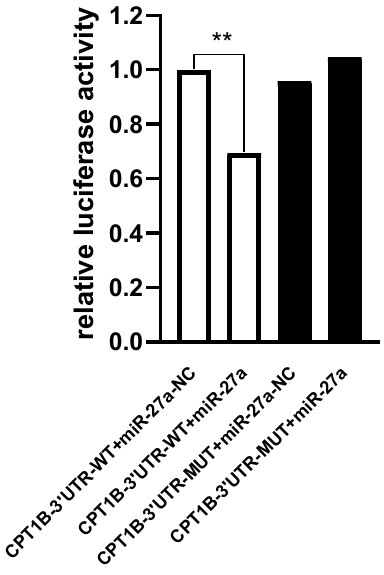
Figure 6. ( A ) Sequence alignment of miR-27a and the 3 ′ -untranslated region (UTR) of CPT1B as determined by Target Scan software and miRDB target prediction database; ( B ) changes in luciferase activity after ovine preadipocytes cells were co-transfected with miR-27a mimic and a luciferase reporter with a fragment of the CPT1B 3 ′ -UTR harboring either the miR-27a binding site ( CPT1B -3 ′ UTR-WT) or a mutant ( CPT1B -3 ′ UTR-MUT). ** p < 0.01. SV40: Simian virus 40; poly A: polyadenylic acid.